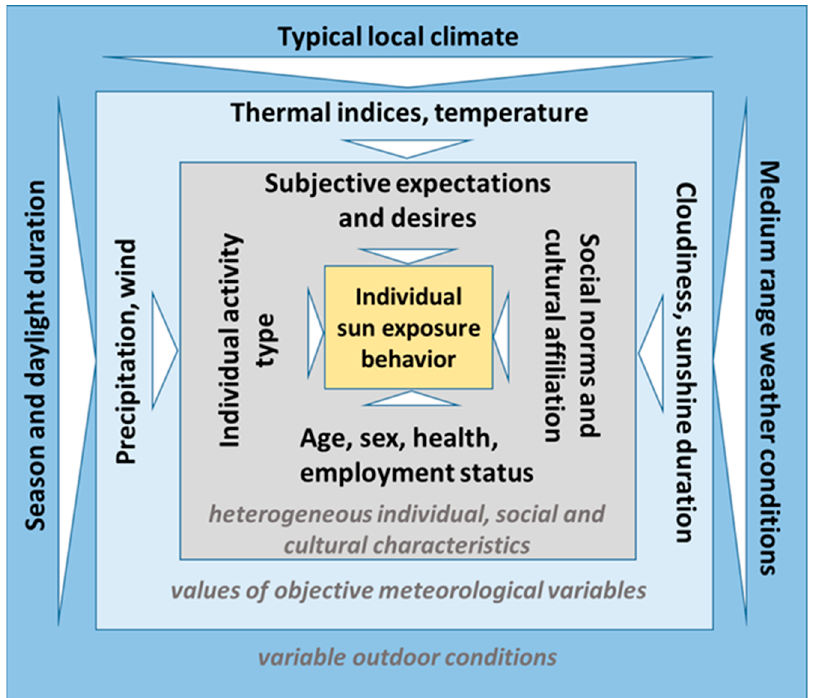
Figure 4. Influence on the individual solar UVR exposure behavior through the combination of objective, but variable, external outdoor conditions and heterogeneous individual, social and cultural characteristics.